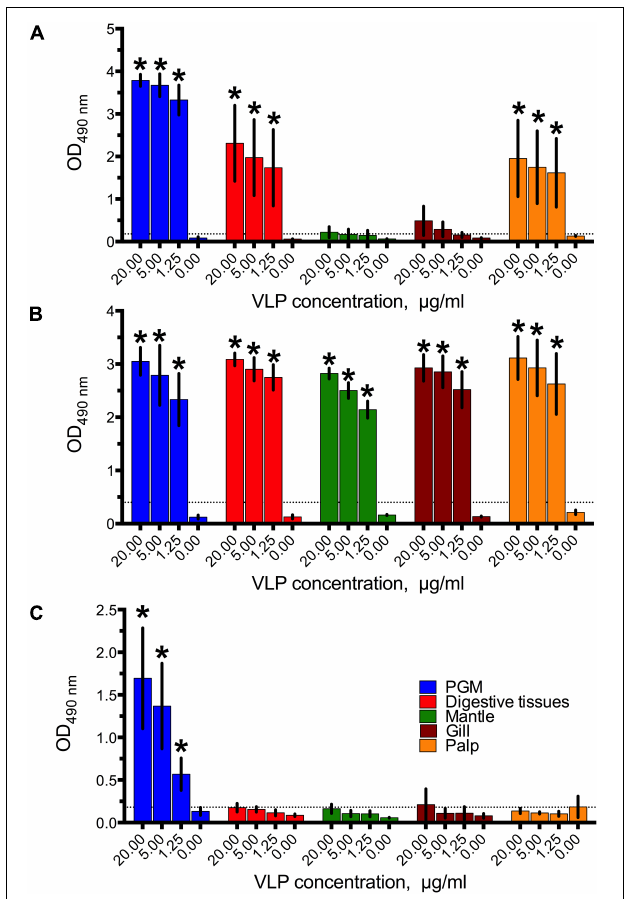
FIGURE 1 | The binding of (A) GI.1West Chester VLPs, (B) GII.4 Sydney VLPs, (C) and GII.17 Kawasaki308 VLPs to digestive tissues, gills, mantle, and palp tissue extracts. All data are given as mean from five-six oysters measured separately ± standard deviations (SD), Asterisks indicate statistically significant differences (comparison to PBS control, p < 0.05).